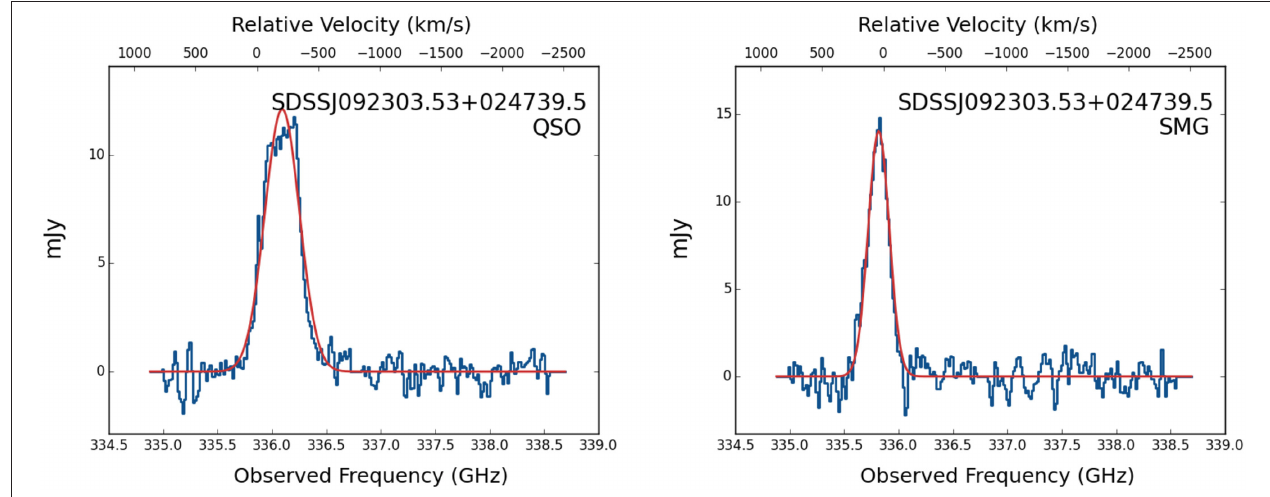
FIGURE 4 | Spatially-integrated spectra of the [C II ] emission line in the quasar host (left) and the interacting companion (right) of J0923. The relative velocities (top x -axis) are calculated relative to the rest-frame UV Mg II λ 2798 broad emission line of the quasar. These data confirm the physical association of the companion source to the quasar